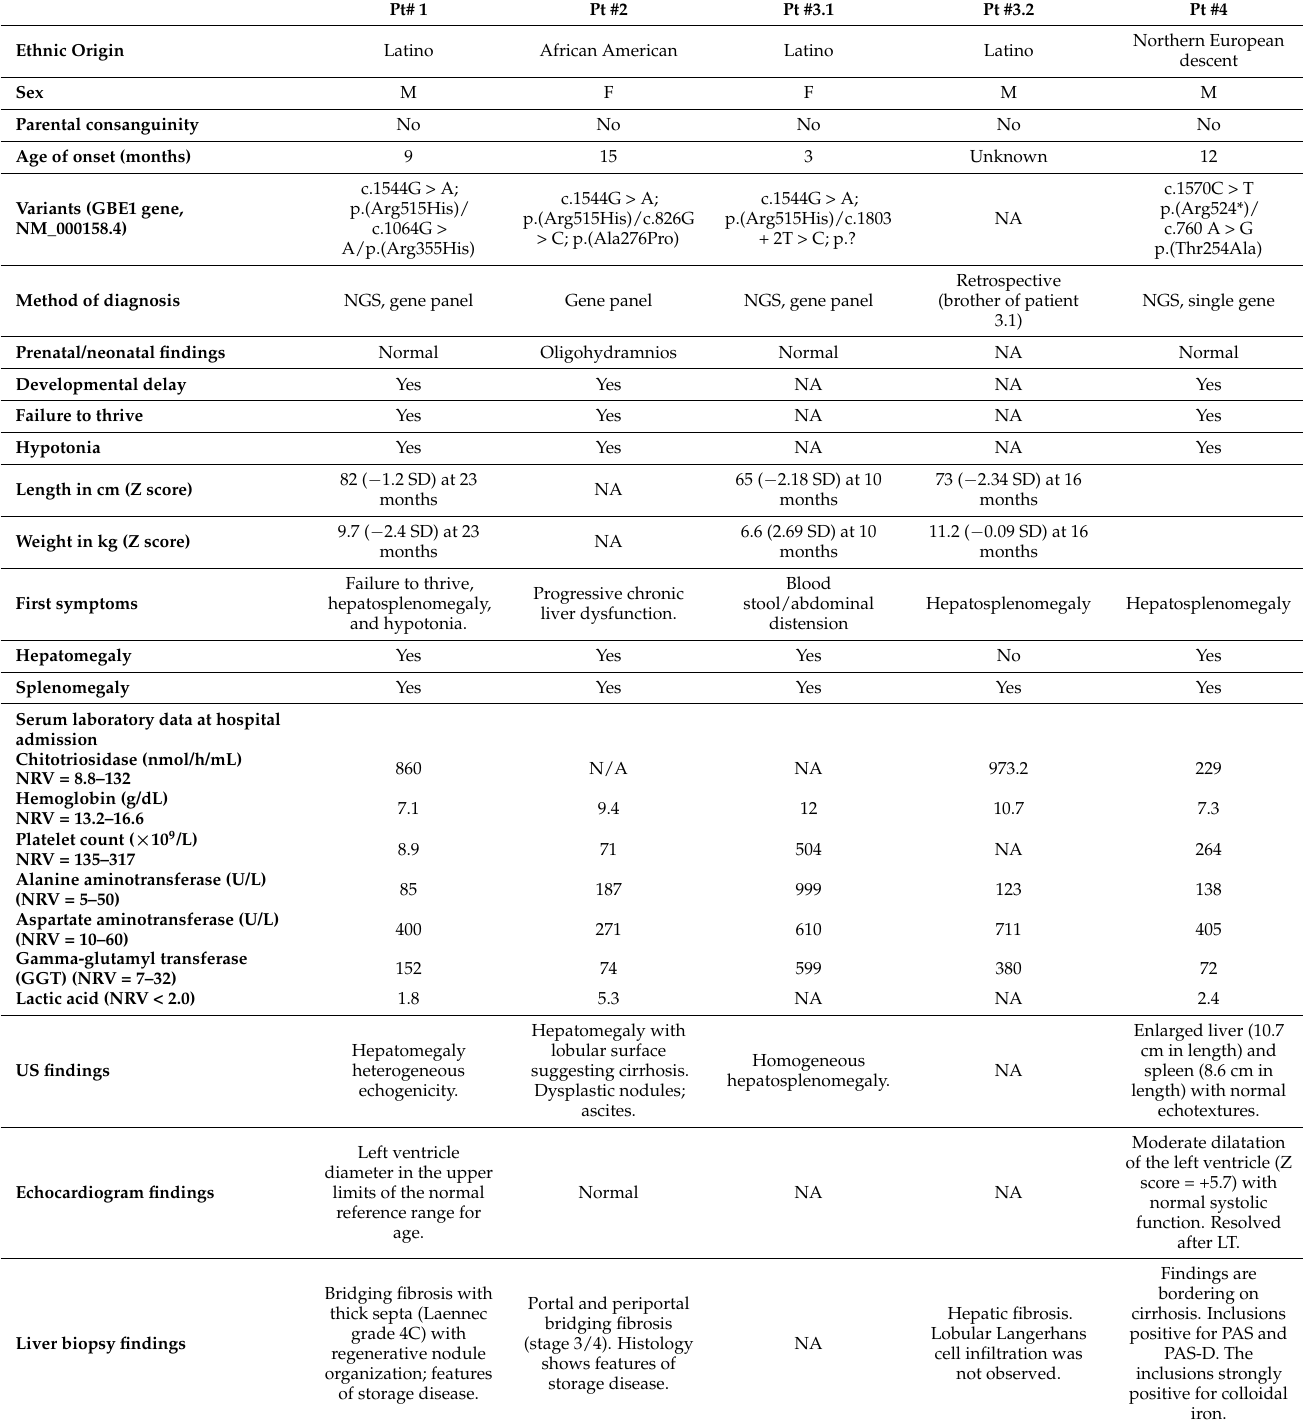
Table 1. Patients’ demographic and clinical